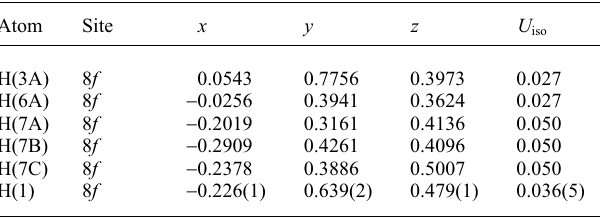
Table 3. Atomic coordinates and displacement parameters (in Å 2 ) .